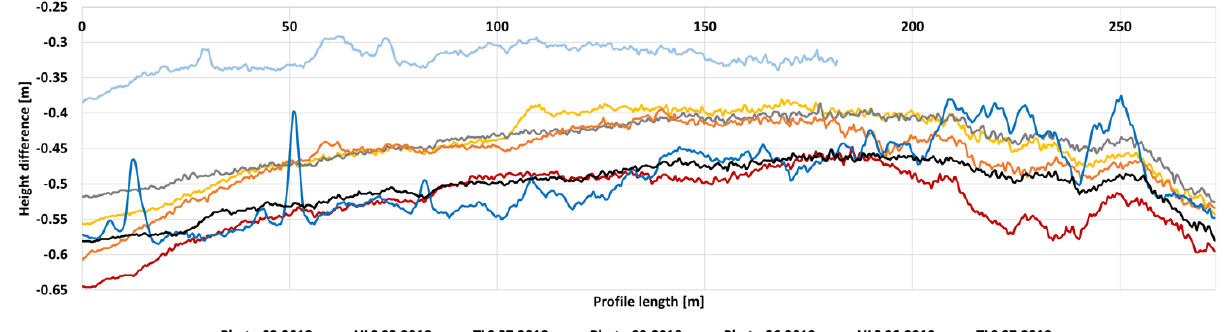
Figure 11 . Example cross-sections of differential models created with respects to ALS data for the main road crossing the scene from west to east.